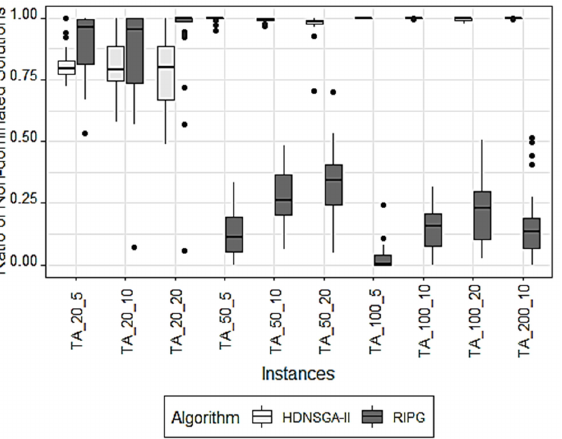
Figure 4. Comparison of the non-dominated solutions ratio evolution with HDNSGA-II and RIPG in each type of instance.